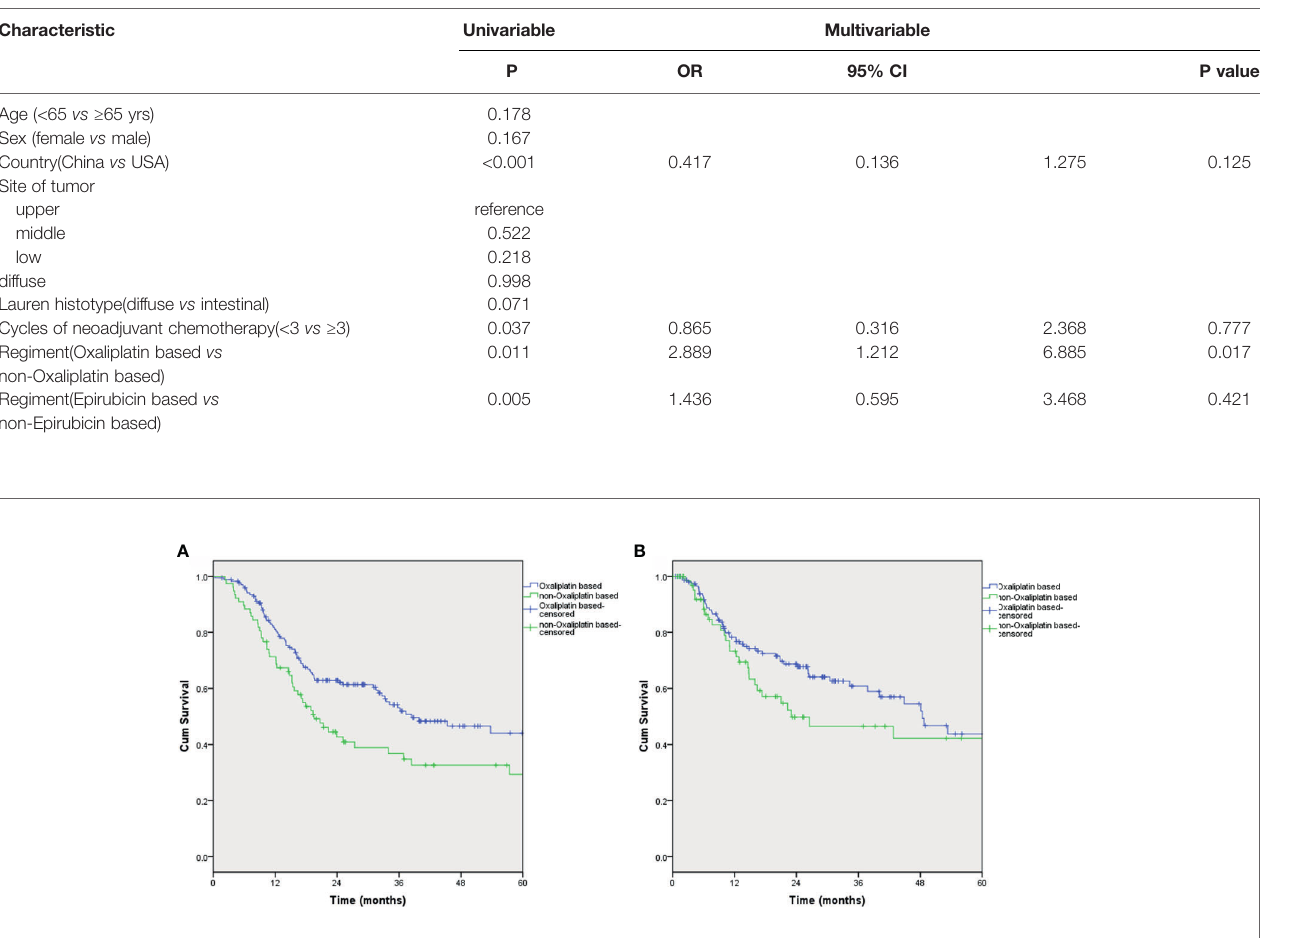
TABLE 4 | Univariate and Multivariate Analysis for Predictors of TRG.